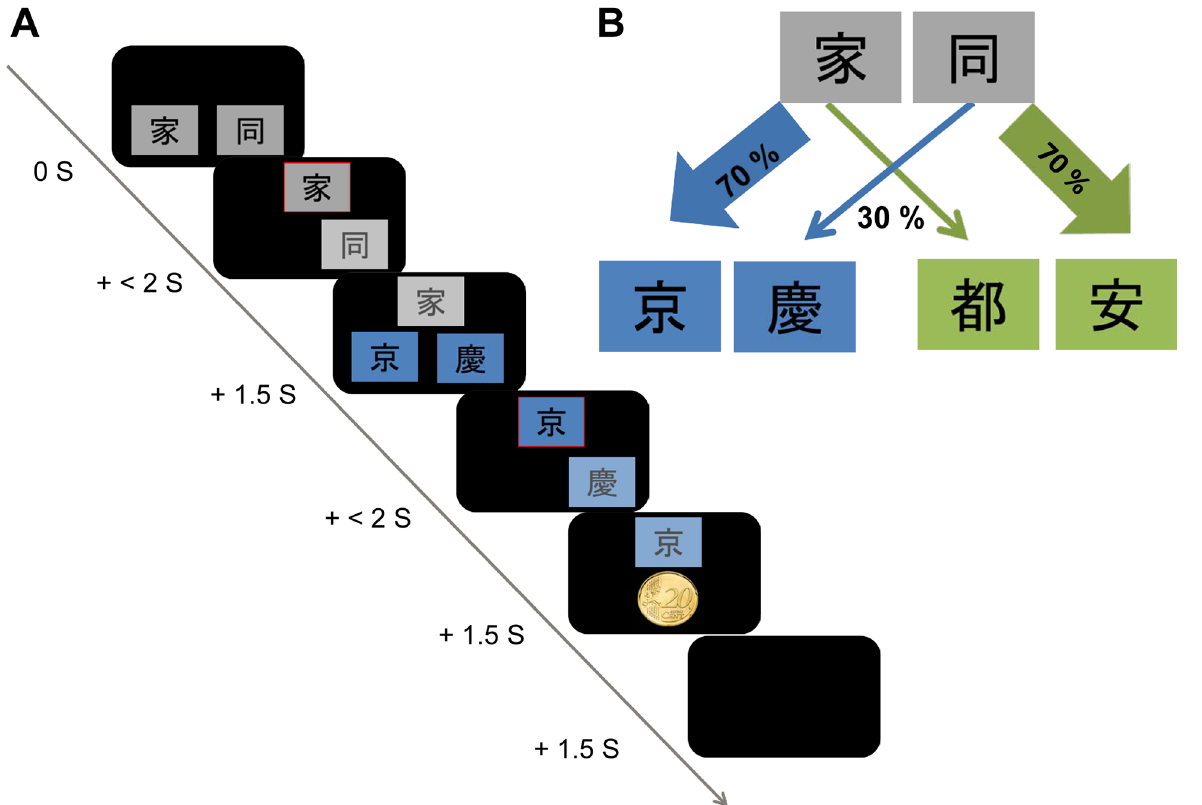
Fig 1. Two-step decision task. (A) Trial structure. Each trial consisted of choices at two steps. Step 1 involved the first choice between two abstract gray stimuli (Chinese characters, not known to German subjects). The chosen stimulus was framed with red color in the center-top of the screen for 1.5s. Subsequently, subjects were presented with another stimulus pair in step 2. The second choice was rewarded with money (20 cents) or nothing. ( B ) The transitions from step 1 to step 2 remained fixed, with 70% and 30% of all trials as respectively common and rare transitions. The reward probabilities for each stimulus in step 2 changed independently between 25% and 75%, based on Gaussian random walks with reflecting boundaries [10]. Win probabilities varied, therefore, as a function of the trial number.